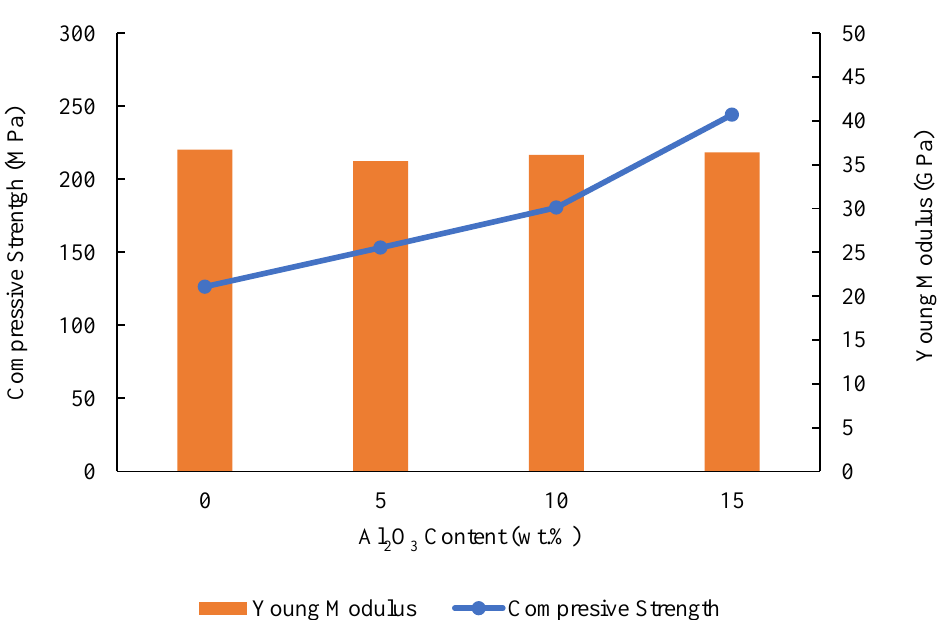
Figure 6. Compressive strength and Young modulus of Mg-Zn/HAP/Al 2 O 3 composite with different amounts of HAP and Al 2 O 3 .